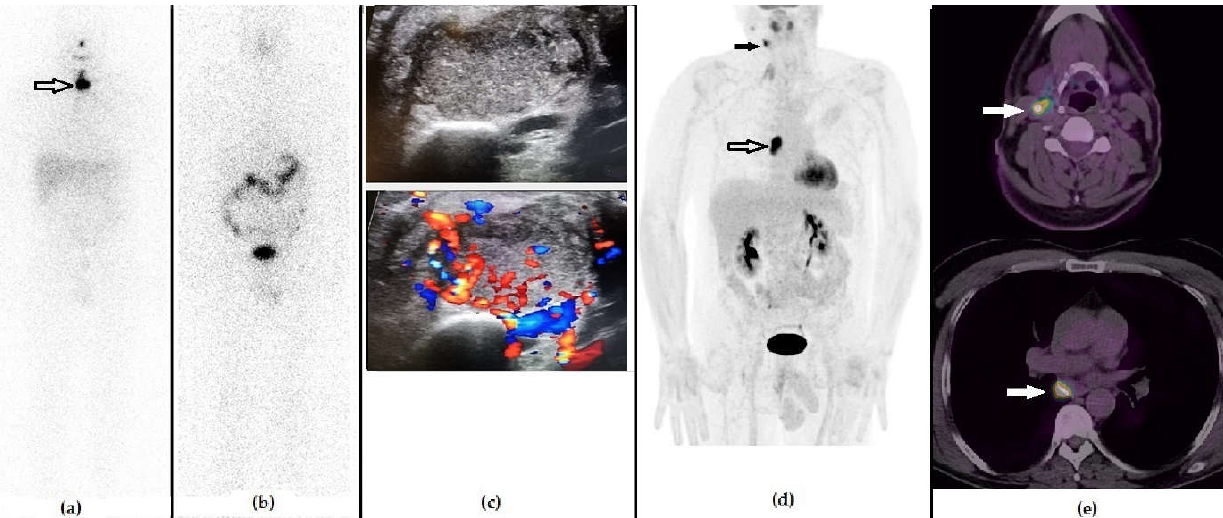
Figure 5. A 56-year-old male that previously underwent a thyroidectomy plus CND and 1 cycle of RAI due to Hürthle cell carcinoma (pT1b N1b). The first panel represents the post-RAI 131 I-WBS showing the residual iodine-avid tissue in the anterior cervical region (( a ), black arrow). Fifteen months after RAI, he presented with a slightly increased value of stimulated Tg serum level (i.e., 3.5 ng/mL), negative 131 I-WBS ( b ) and neck US showing hypervascularized laterocervical node suspected of metastasis. ( c ) 18 F-FDG PET/CT demonstrated a highly increased tracer incorporation in the suspected right laterocervical node, (( d ) black arrow) also revealing metastases to the mediastinal nodes (( d ), black bordered arrow), as evident in the whole body ( d ) and in the fused PET/CT axial images ( e ). The patient underwent surgery, followed by a further cycle of